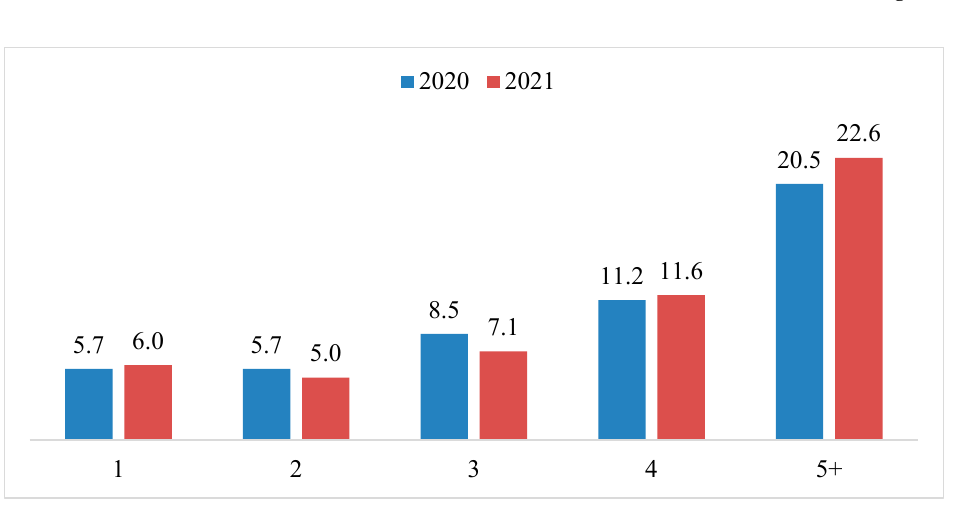
Figure 4. Poverty rate trends, by number of household members, 2020–2021. Source: own elaboration on the Istat database.